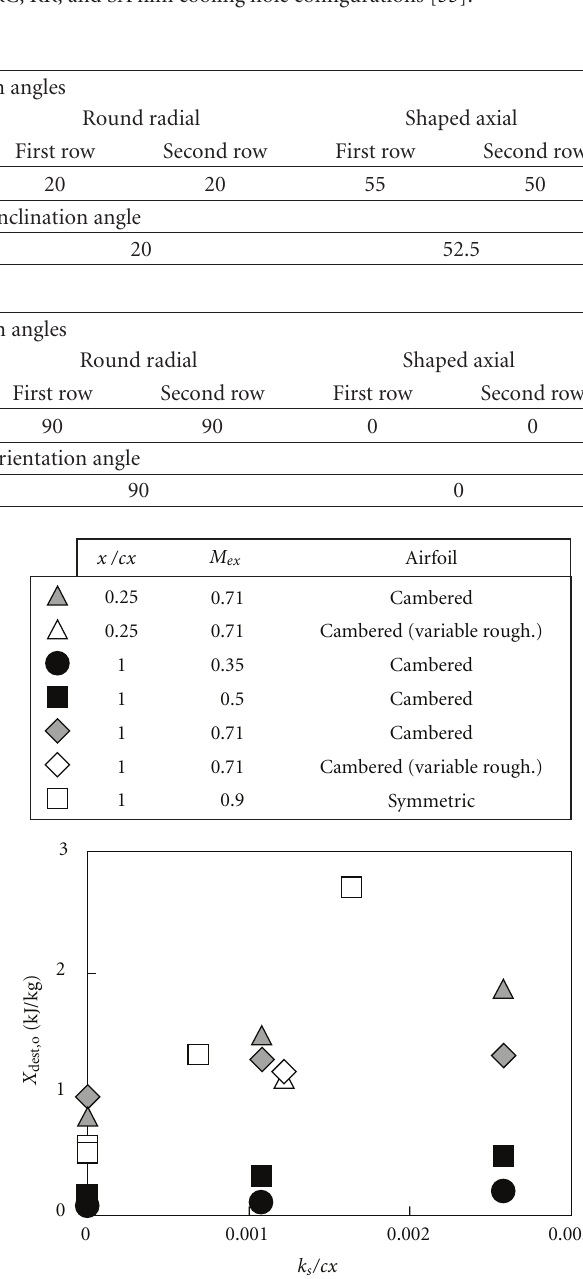
Table 4: Inclination and orientation angles for the RA, RC, RR, and SA film cooling hole configurations [55].